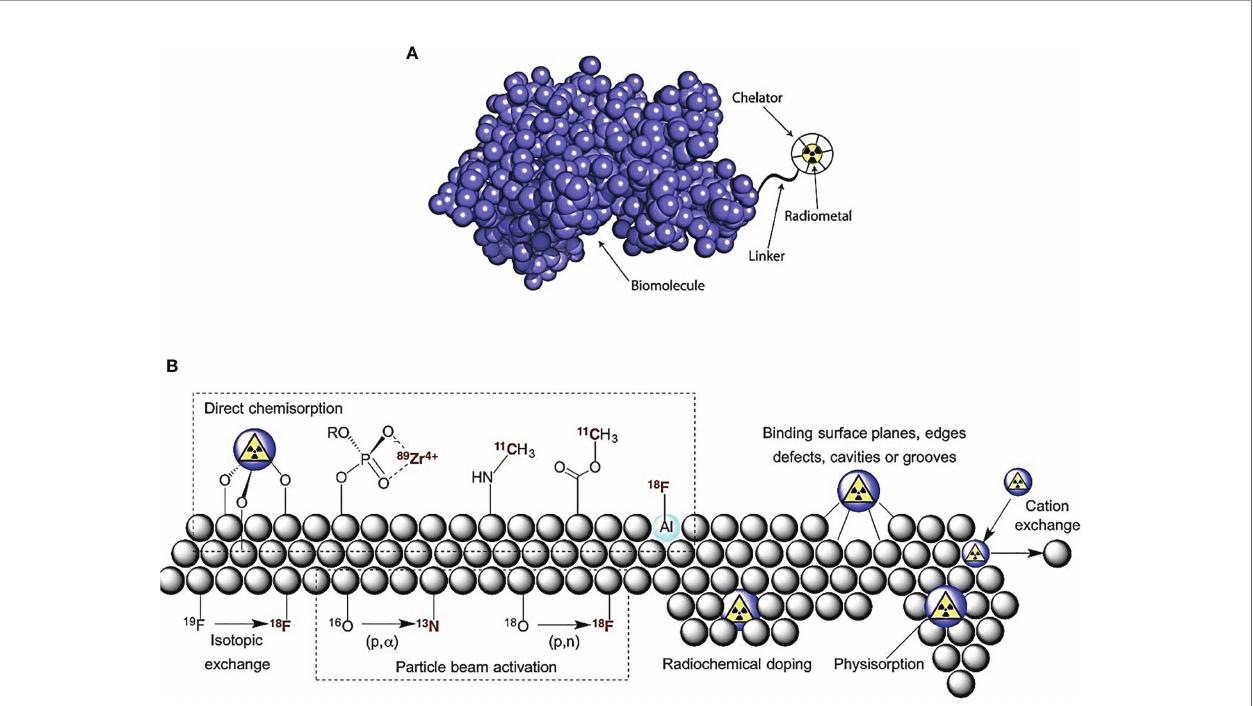
FIGURE 1 | Radiolabeling nanoparticle strategies include the following: (A) indirect radiolabeling by bifunctional chelator — compounds having reactive functional groups that enable them to be covalently linked (conjugated) to biologically relevant vectors (e.g., protein and peptide). (B) Direct radiolabeling via i) chemisorption, high binding af fi nity chemical bonding between nanoparticles and radionuclides; ii) cavity entrapment, entrapment of radionuclides in native cavities or core-shell/ layered nanoparticles; iii) isotopic exchange, exchanging stable and radioactive isotopes of an element in different chemical states; iv) particle beam activation, hadronic bombardment to initiate a nuclear reaction that converts stable isotopes in the nanoparticle lattice into radioactive nanoparticles; v) radiochemical doping, using a radionuclide as a surrogate during the synthesis, yielding inherently radioactive nanoparticles; vi) physisorption, physical bonding to the surface of nanoparticles by Van der Waals forces; vii) cation exchange, cation exchange between the nanoparticle ’ s cation and a different cationic radionuclide [adapted with permission from Lamb et al.